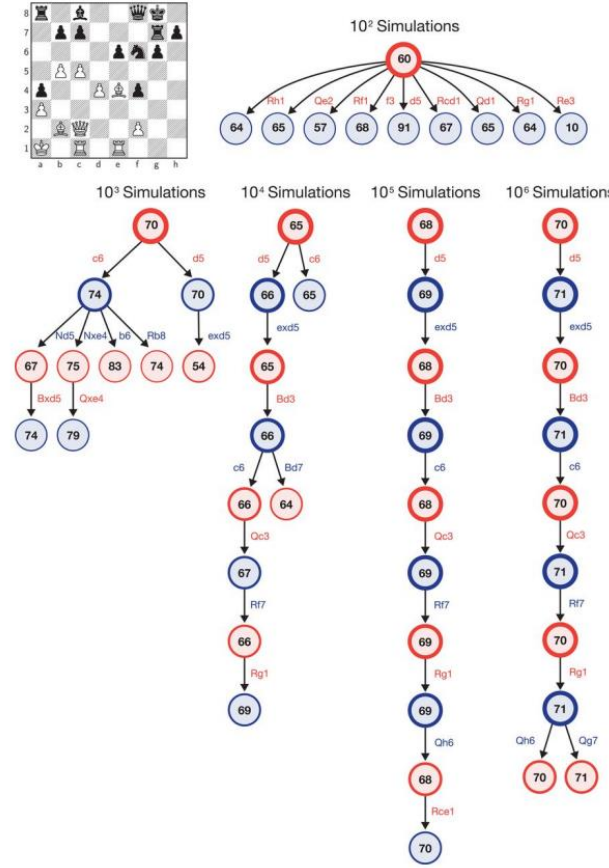
Figure 4. Monte Carlo Tree Search used for a given chess position. This figure shows a Monte Carlo Tree Search being used for a given chess position. Each simulation summary shows the top 10 most visited states and the estimated value for a move that was simulated. Source: [70]. Authors should discuss the results and how they can be interpreted from the per- Table 3. Classical format of a chess game notation. spective of previous studies and the working hypotheses. The findings and their implica- tions should be discussed in the broadest context possible. Future research directions may also be highlighted.